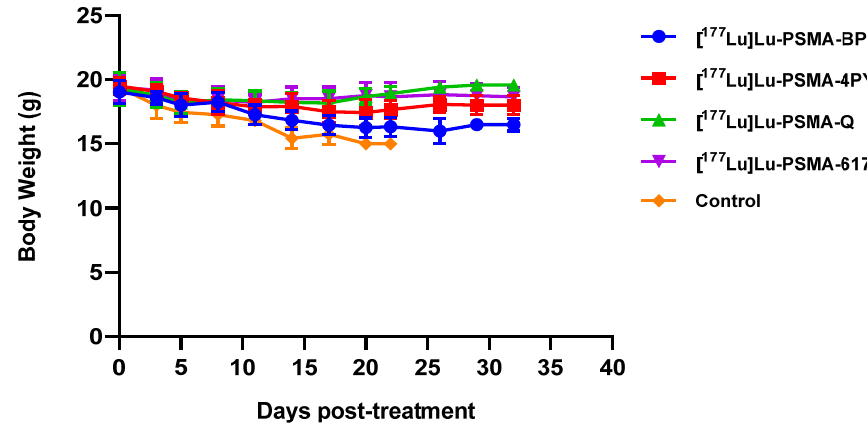
Figure 7. Body weight changes of mice in different